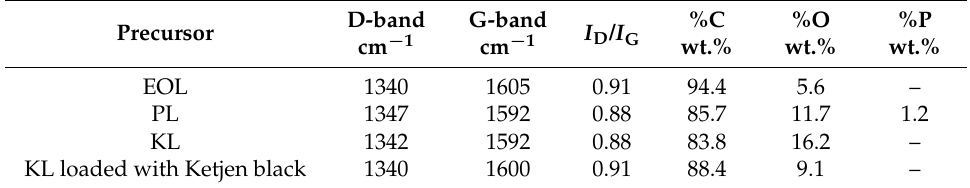
Table 2. Carbon nanotexture (Raman spectroscopy), and wt.% of C, O and P obtained by X-Ray Photoemission Spectroscopy (XPS).